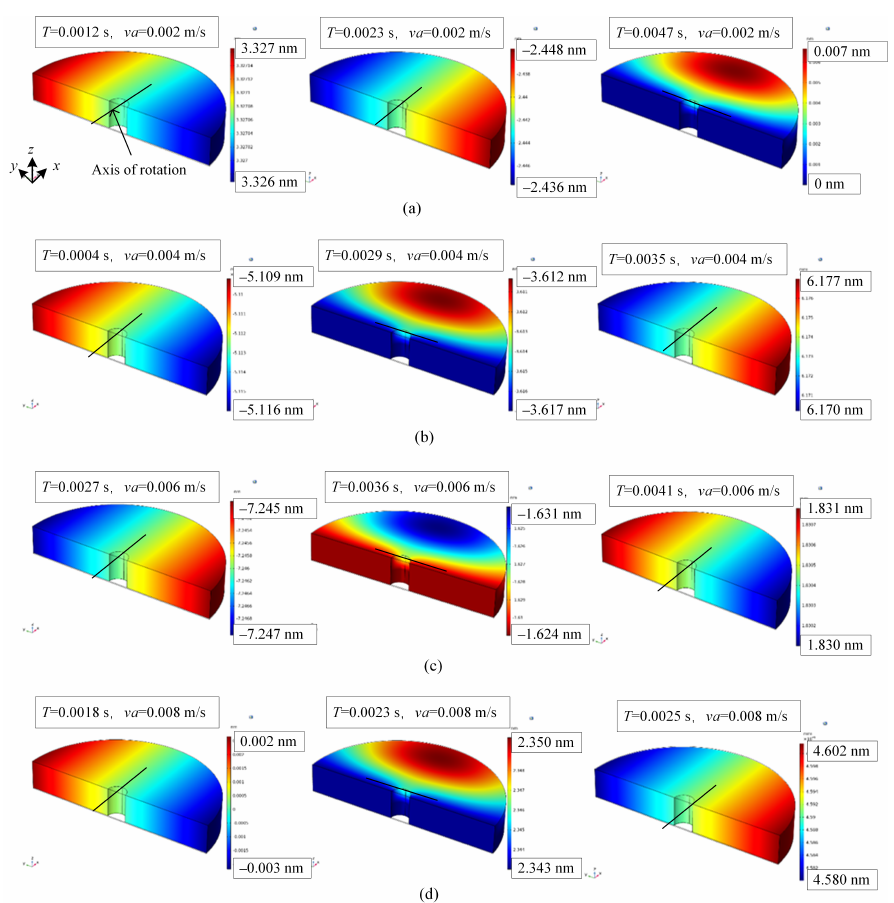
Figure 3. Transient normal vibration A results under different inlet air velocities v a at different instantaneous time T from FEM FSI model: ( a ) v a = 0.002 m/s; ( b ) v a = 0.004 m/s; ( c ) v a = 0.006 m/s; and ( d ) v a = 0.008